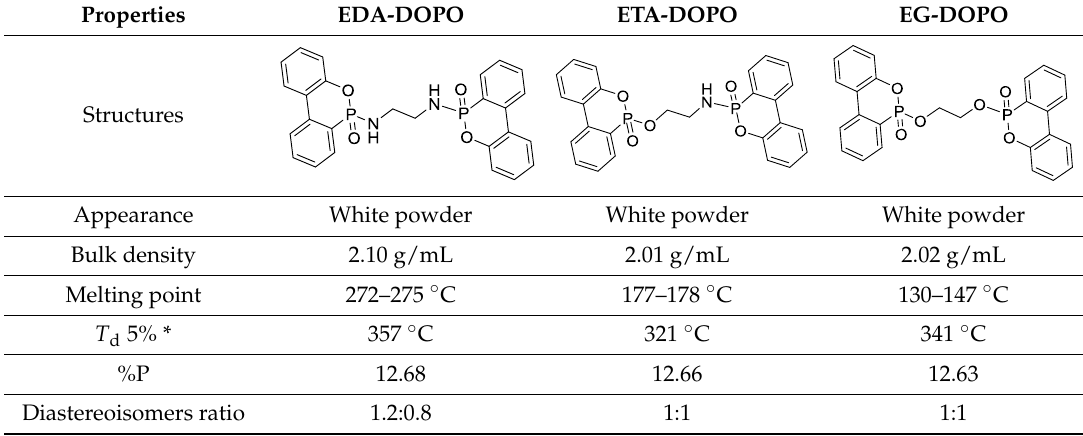
Table 1. Structure, physical properties, and chemical characteristics of the bridged-DOPO flame retardants.